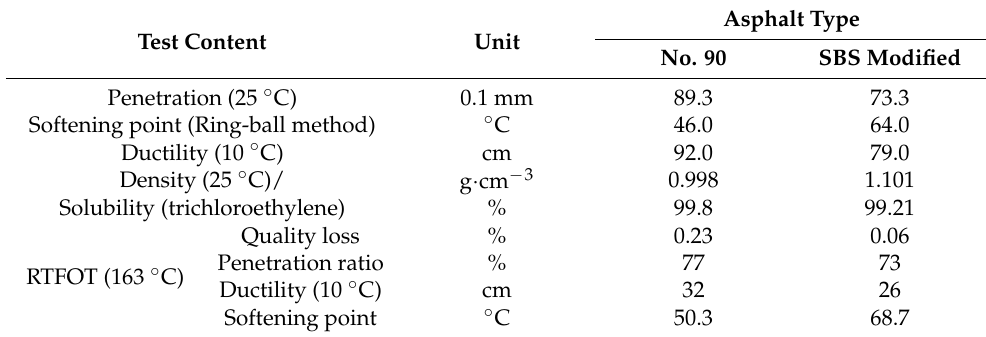
Table 1. Technical index value of asphalt.